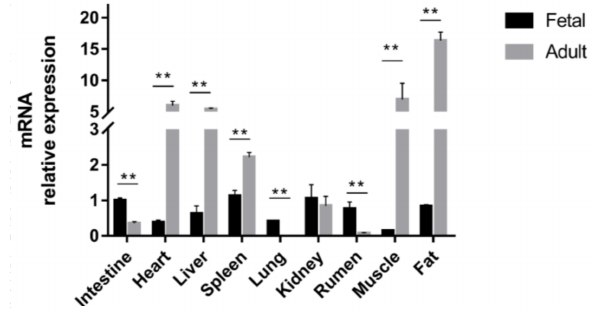
Figure 5. Differential STAT3 mRNA expression across tissues of Qinchuan cattle ( n = 3). Double asterisks (**) indicate significant differences between fetal and adult stages ( p < 0.01).